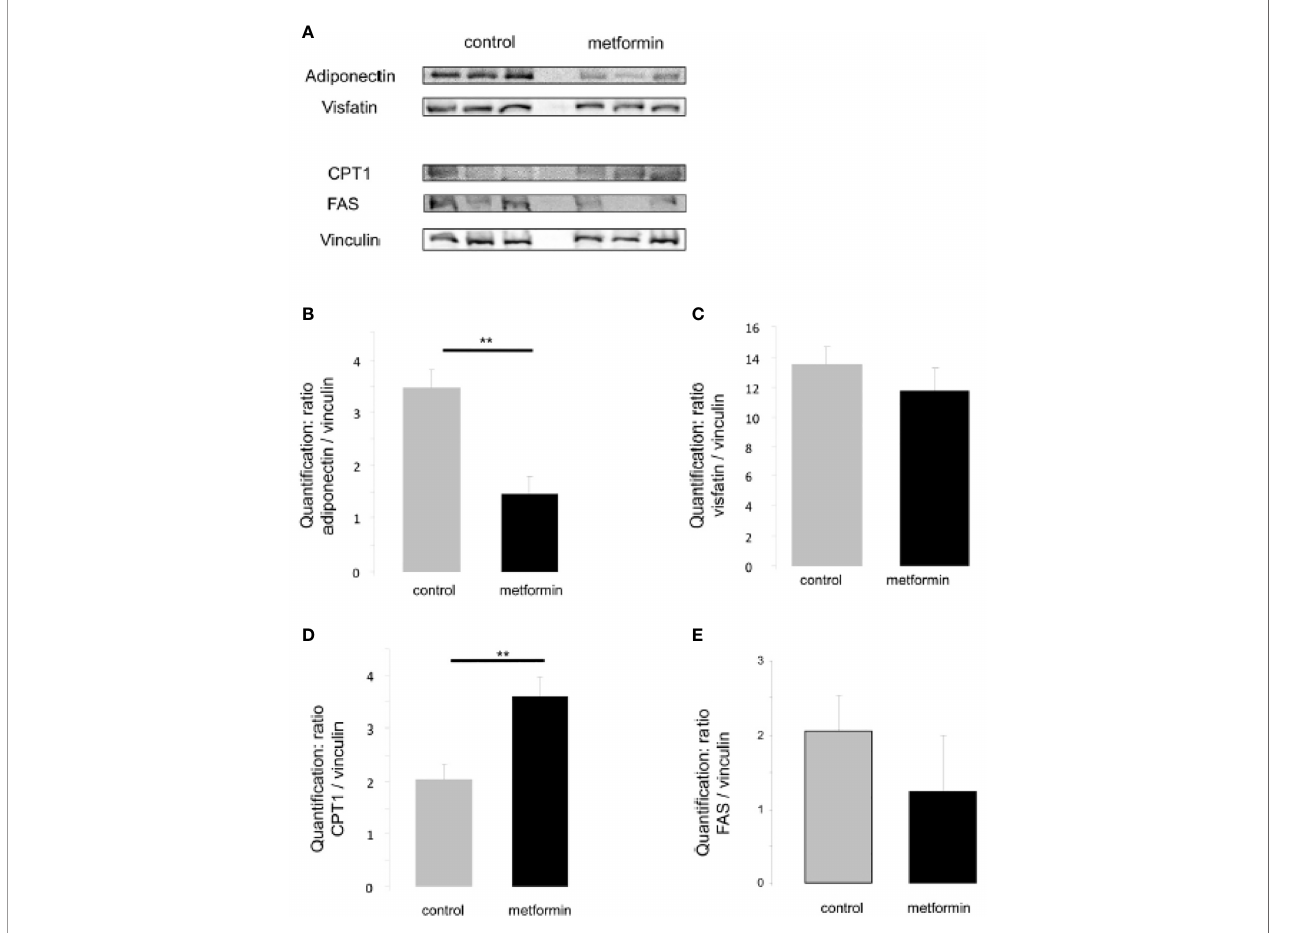
FIGURE 4 | Expression of metabolic adipocyte markers in adult males exposed in utero . (A) Representative protein analysis (cropped blots) of adiponectin, visfatin, CPT1, FAS in adipose tissue extract from male mice that were exposed to metformin in utero (B – E) Quanti fi cation of proteins normalized against vinculin. (n=4-7). **p <